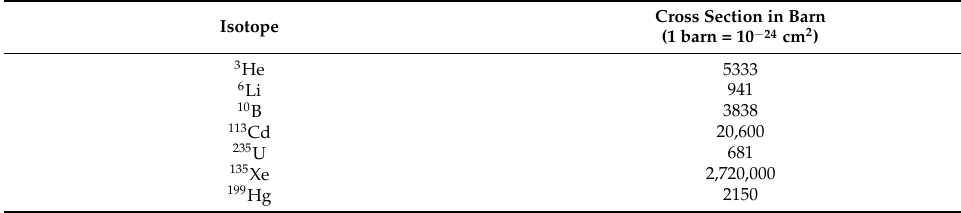
Table 1. Thermal neutron absorption cross-section for different isotopes [7]. Isotope Cross Section in Barn (1 barn = 10 − 24 cm 2 )